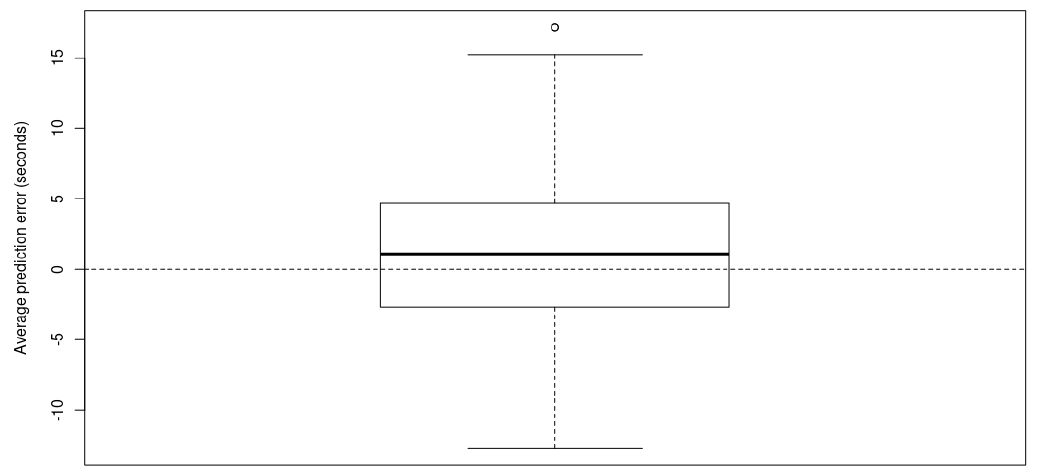
Figure 14. Boxplot of the difference in the average prediction errors of route travel time with GM and M (median value: